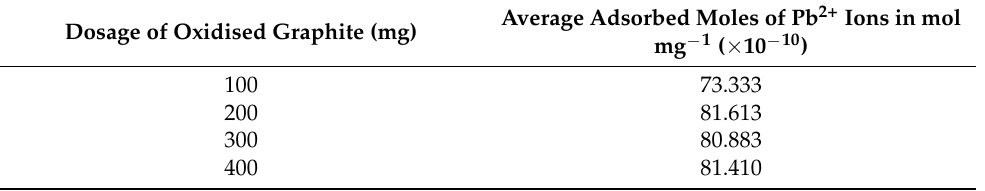
Table 2. Average adsorbed moles of Pb 2+ ion (initial concentration of 100 µ M) versus dosage of oxidized graphite (between 100.0 mg and 400.0 mg).